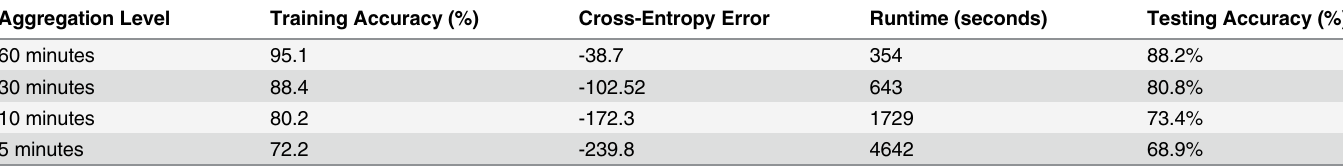
Table 1. Comparison of traf fi c congestion prediction performance with different data aggregation levels. Aggregation